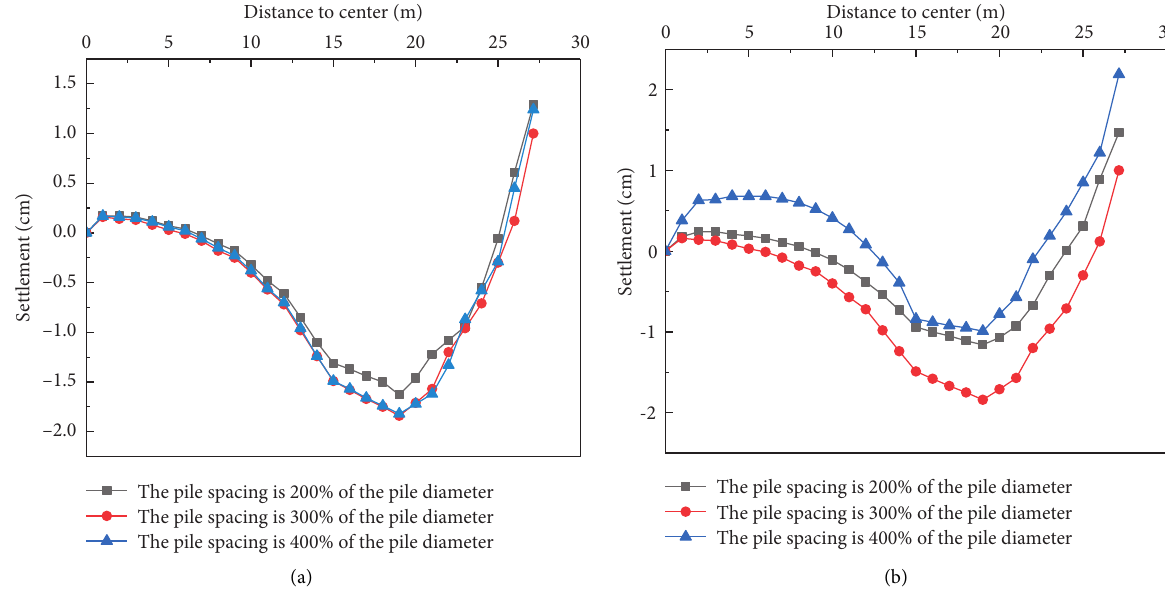
Figure 9: Postconstruction differential settlement diagram of the foundation surface under different piles spacings. (a) Varying the pile spacing under the existing road slope. (b) Varying the pile spacing under the existing subgrade and new embankment.